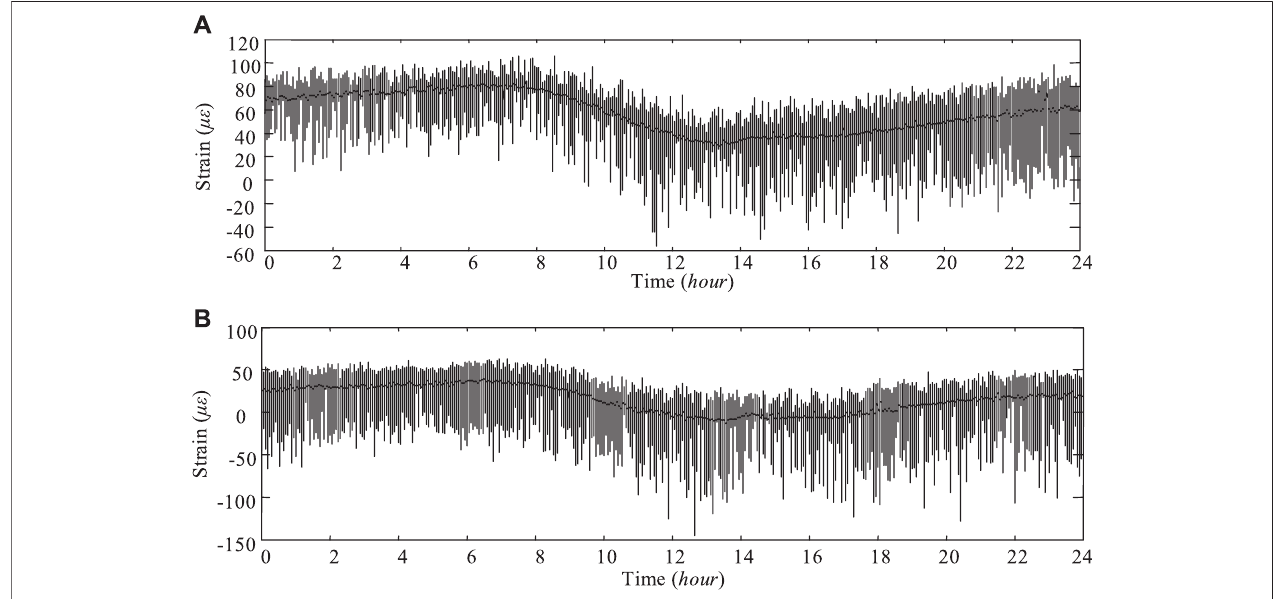
FIGURE 4 | Typical daily strain time histories: (A) Sensor RD d , (B) Sensor RD u .